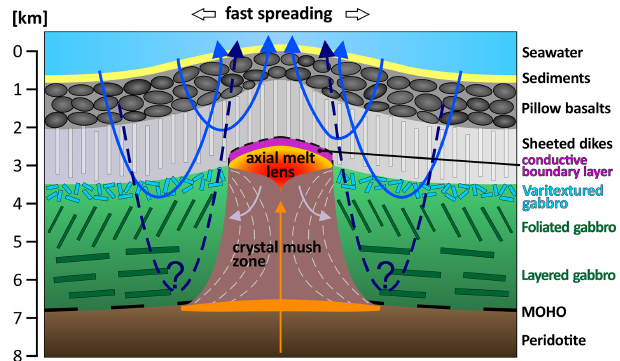
Figure 1. Schematic cross-section of typical fast-spreading oceanic crust showing the location of the axial melt lens (AML) sandwiched between the gabbros and the sheeted dikes (not to scale). The conductive boundary layer typically consists of hornfels (contact- metamorphosed and recrystallized sheeted dike). Blue arrows indi- cate hydrothermal circulation pathways. Whether a deep hydrother- mal circulation exists (dashed blue arrows) is currently under dis- cussion. The orange arrow corresponds to the path of the upris- ing melt. Dashed white curves in the crystal mush zone show isotherms, and the gray arrows indicate migration paths of crys- tallized phases. The investigated drill core covers the transition be- tween sheeted dikes and the varitextured gabbros. Modified after Zhang et al.